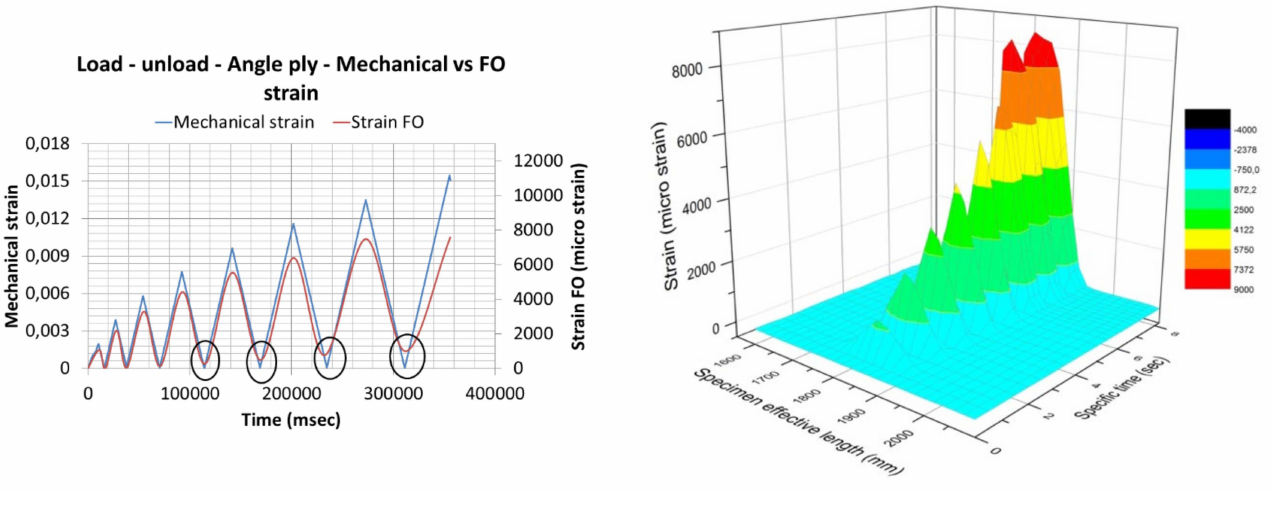
Figure 19. Load–unload test curve for smart angle-ply specimen along with the 3-D load–unload